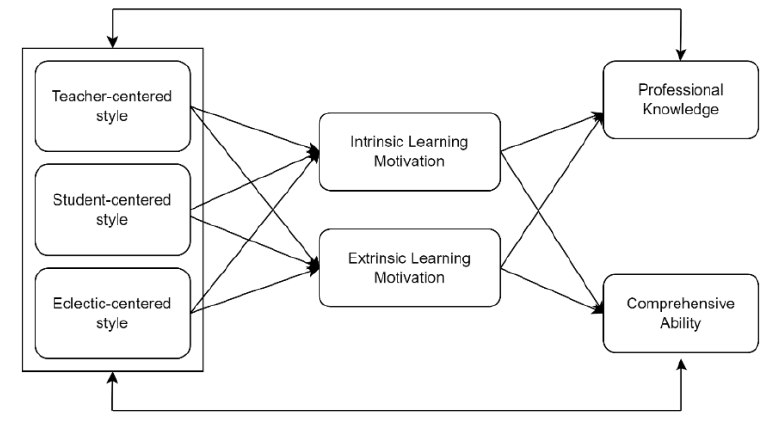
Figure 1: Research Framework of this Study; Source: